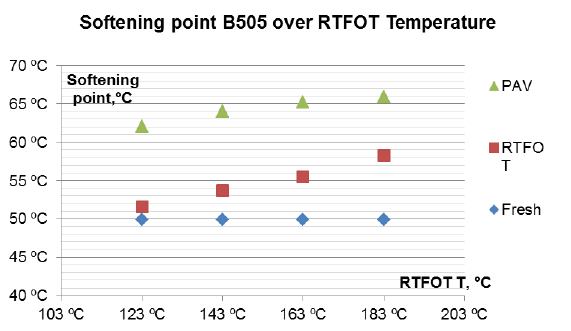
Figure 4. Softening point change with RTFOT